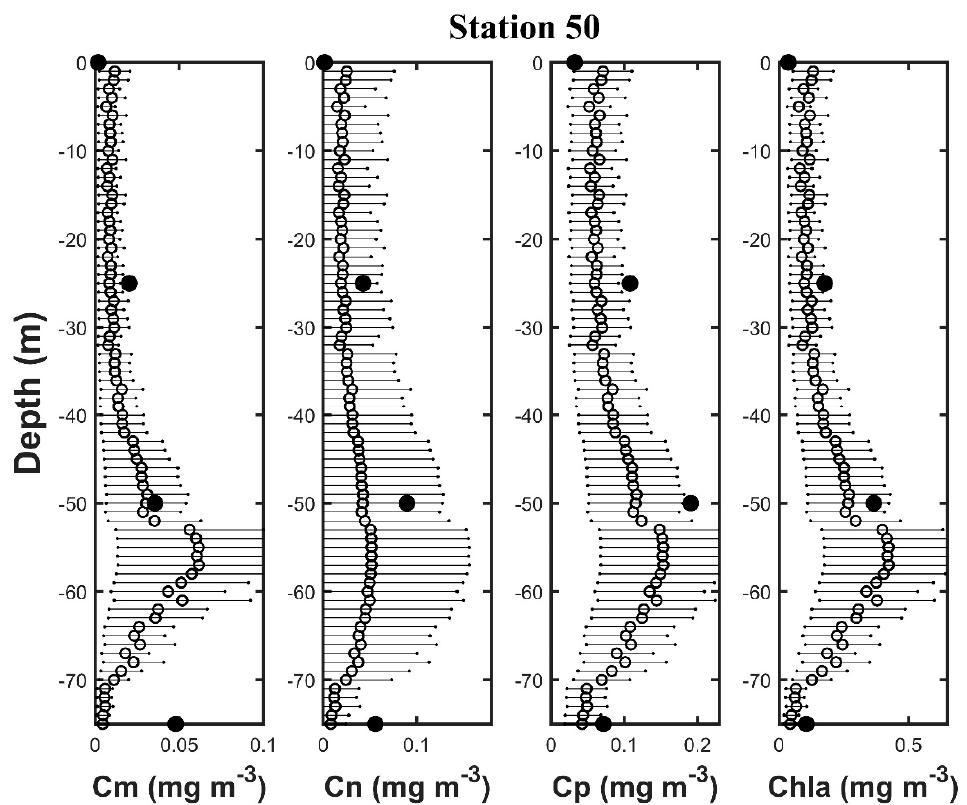
Figure 8. The vertical distribution of PSC and Chla retrieved by SVM-Bricaud95 at Station 50. The solid circles represent the PSC measured using the HPLC method. The open circles represent the profile PSC derived from SVM-Bricaud95. The dotted lines represent the range within one-fold APD. The PSC was dominated by Cp, with a maximum value close to 0.2 mg / m 3 , and both Cn and Cm occupied a minority of the population (Cn: 0.1 mg / m 3 and Cm: 0.07 mg / m 3 ,